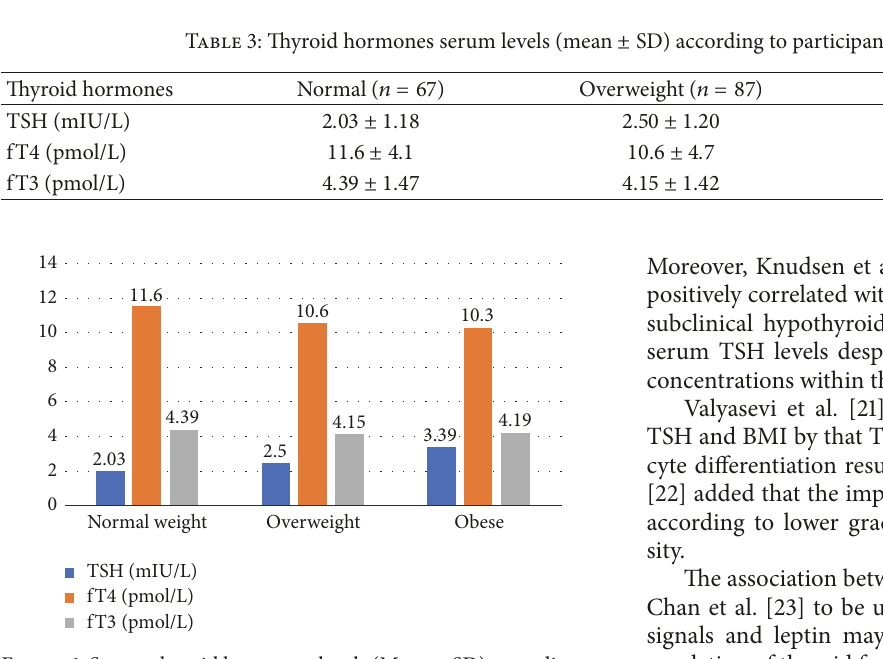
Figure 1: Serum thyroid hormones levels (Mean ± SD) according to grades of body mass